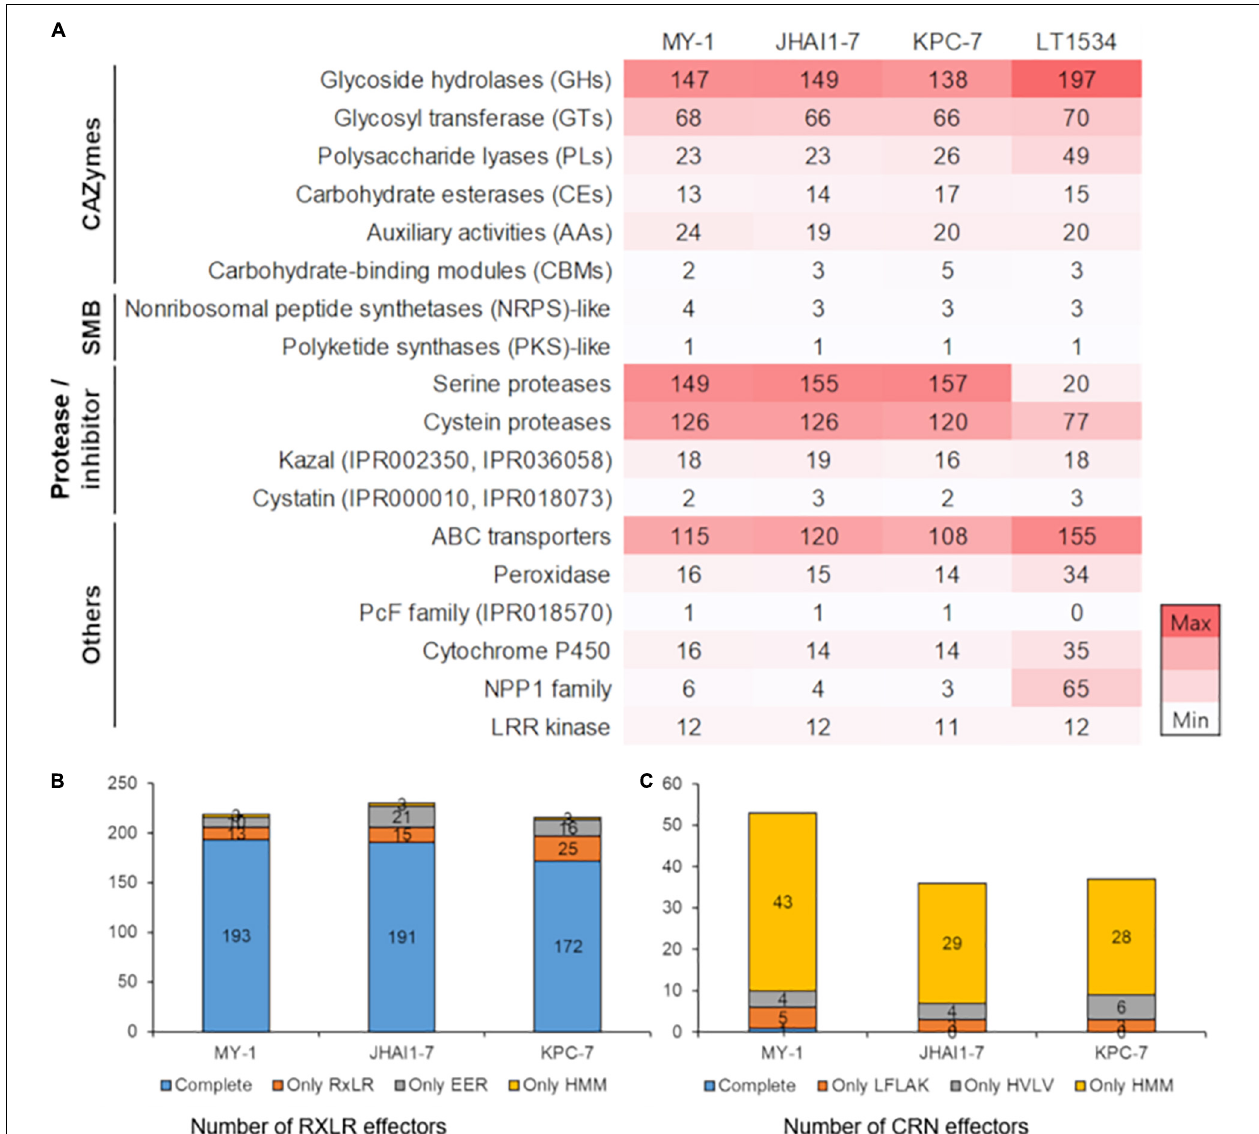
FIGURE 3 | Composition of the pathogenicity-related protein families in four P. capsici isolates. (A) The number of annotated genes in four P. capsici isolates, including the reference genome. A darker color represents a higher number of genes in the protein families. CAZymes, carbohydrate-active enzymes; SMB, secondary metabolite biosynthesis genes. The number of annotated genes is represented by the color intensity from white (low) to red (high) color. (B) The number of RxLR effector genes in three P. capsici isolate genomes. Complete: both RxLR and EER sequence motifs were detected; Only RxLR: only RxLR sequence motifs were detected; Only EER: only EER sequence motifs were detected; Only HMM: no sequence motifs, but HMM profiles were detected. (C) The number of CRN effector genes in three P. capsici isolate genomes. Complete: both LFLAK and HVLV sequence motifs were detected; Only LFLAK: only LFLAK sequence motifs were detected; Only HVLV: only HVLV sequence motifs were detected; Only HMM: no sequence motifs, but HMM profiles were